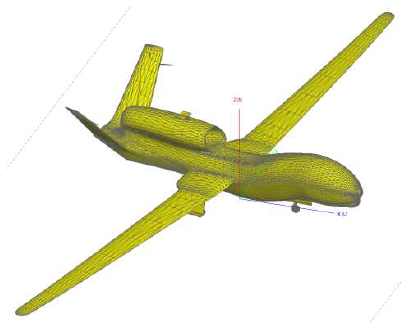
Figure 6. Target CAD model.